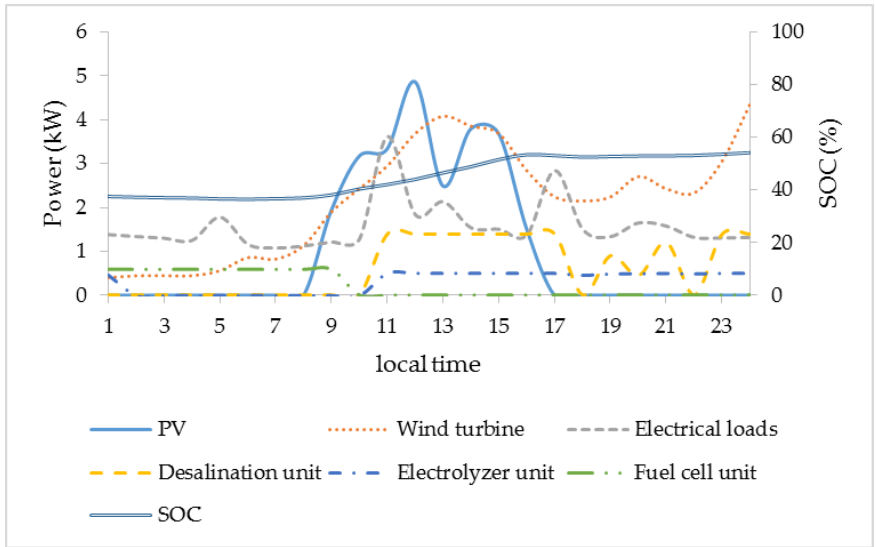
Figure 11. Power variations during a winter day.